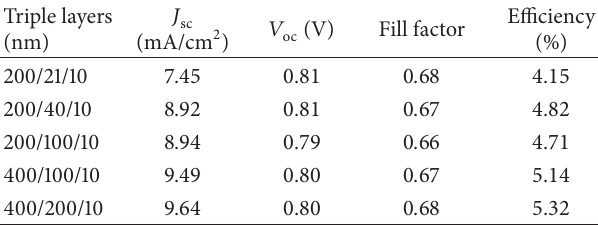
Table 5: Solar performance parameters of the DSSCs with triple- particle sizes in the first (bottom), layer structures of different TiO 2 second (middle), and third